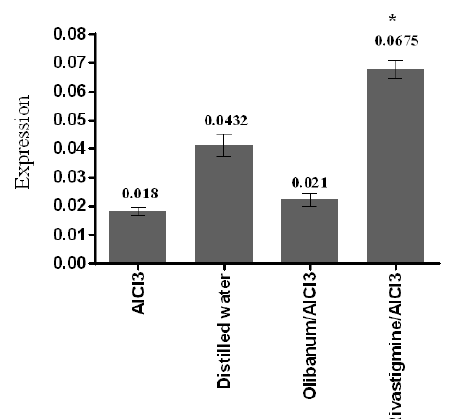
Fig. 4. Effect of the protective protocol treatments of Rivastigmine and Frankincense on the FMR1 gene expression: Olibanum/AlCl ; rats received 3 Frankincense for 2 weeks which were then continued together with AlCl treatment for another 8 weeks. 3 Rivastigmine/AlCl ; rats received Rivastigmine for 2 3 weeks which were then continued together with AlCl treatment for another 8 weeks. Results were 3 reported as mean ± SD. *; p<0.05.